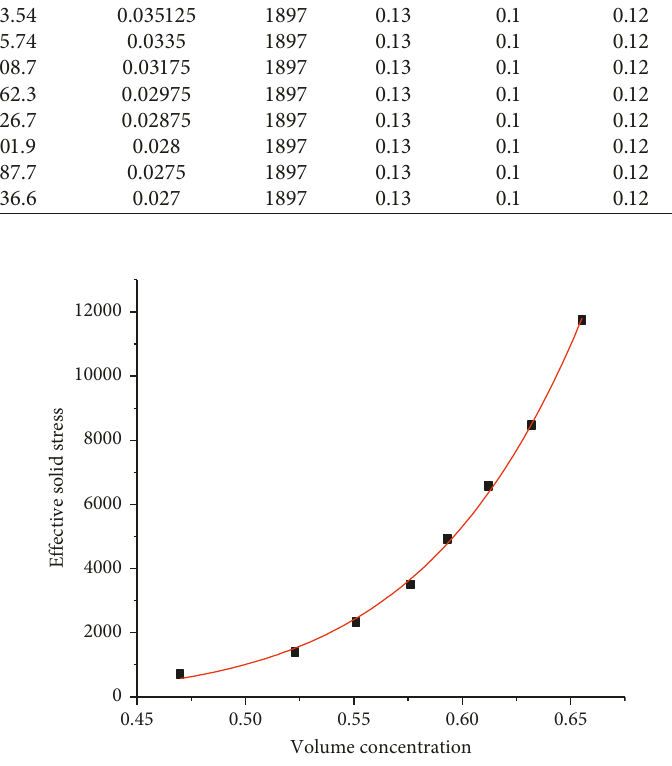
Figure 2: Experimental data obtained from batch centrifuge experiments and curve of